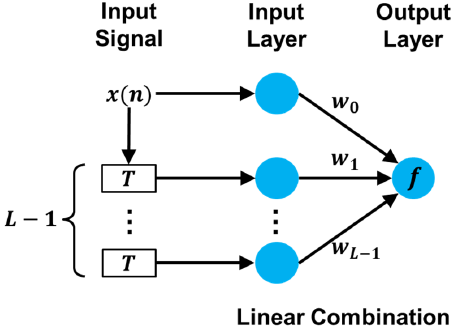
Figure 7. Structure of NN-based FFE.